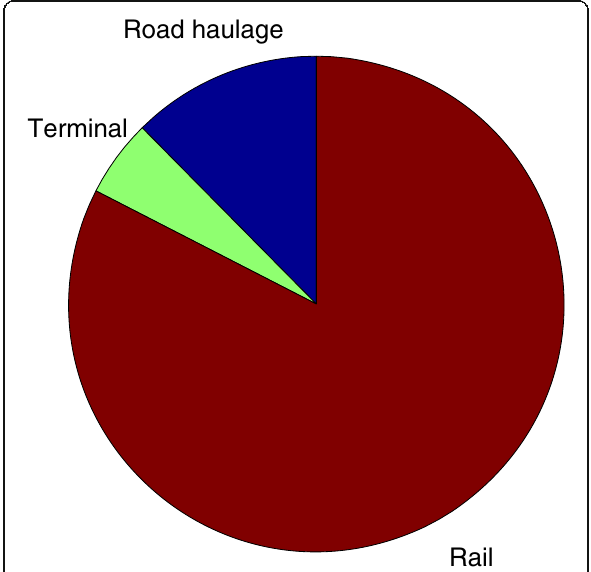
Fig. 9 Influence of each cost item on the final